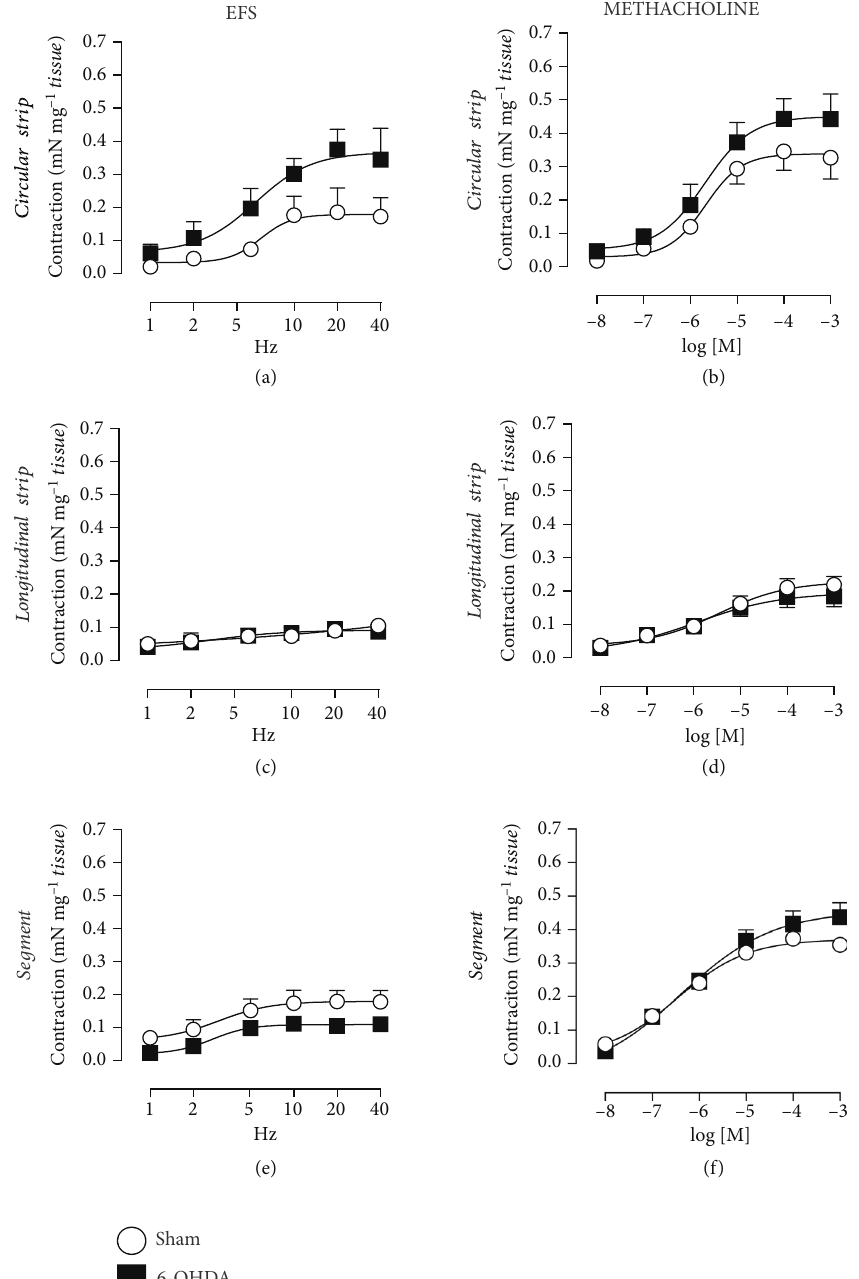
Figure 4: Proximal colon contractile responses to electrical fi eld stimulation (EFS) and methacholine. EFS in the circular strips showed a trend for increased contractile responses in the 6-OHDA ( n = 7 ) as compared with Sham animals ( n = 6 ; a), whereas the proximal colon segments displayed a non-signi fi cant decreased response in the 6-OHDA animals ( n = 9 ) compared with Sham animals ( n = 8 ; e). The methacholine-induced contraction in the circular strips (b: 6-OHDA, n = 10 ; Sham, n = 7 ) and the segments (f: 6-OHDA, n = 11 ; Sham, n = 11 ) was not signi fi cantly changed between the groups. No changes were observed in the longitudinal strips either by EFS (c; 6- OHDA, n = 7 and Sham, n = 6 ) or methacholine-induced contraction (d; n = 10 in each group); two-way ANOVAs a: group F ð 1, 11 Þ = 3 : 30 , p = 0 : 0966 ; (e) group F ð 1, 15 Þ = 3 : 41 , p = 0 : 0848